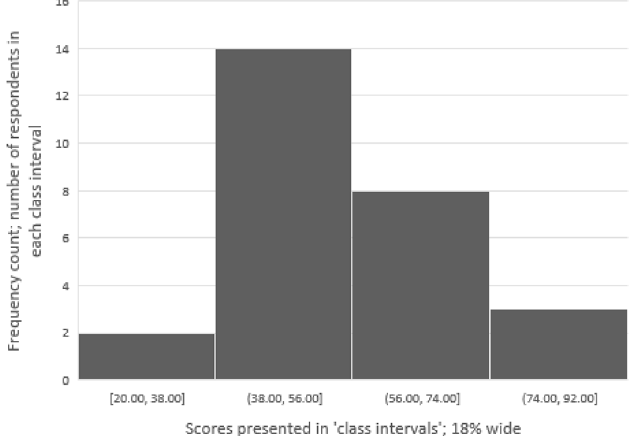
Fig. 2. Histogram to indicate mean scores for individual respondents for VAR 1 the extent to which there is commitment to environmental management.